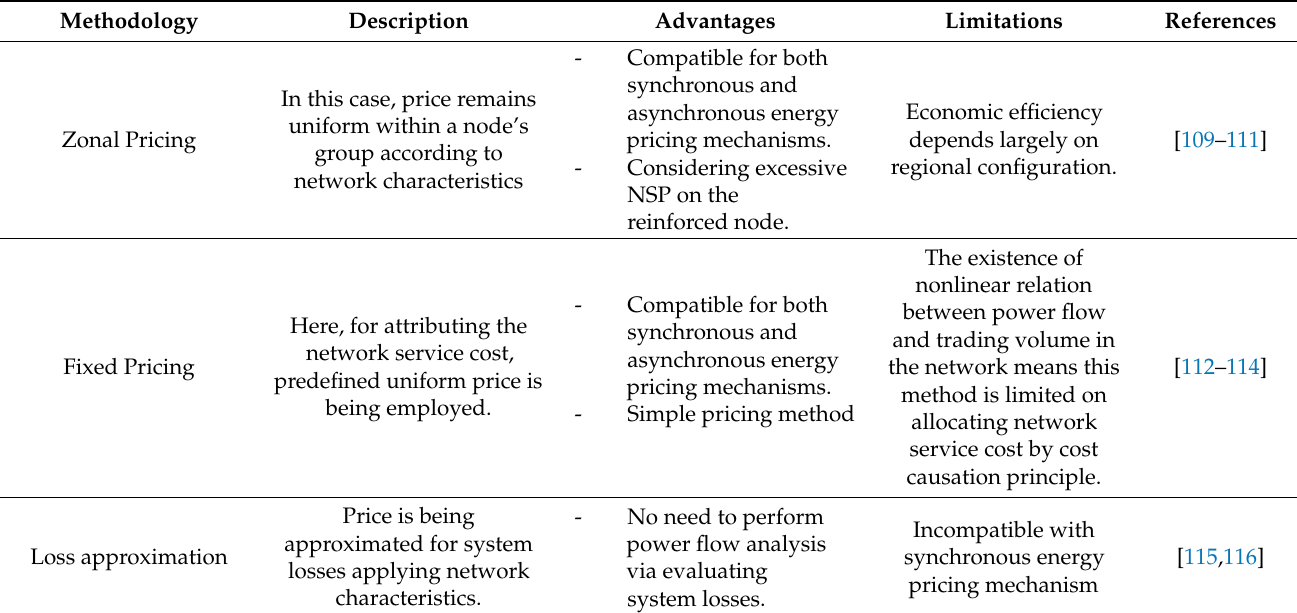
Table 4. Summary of ex-ante network service pricing